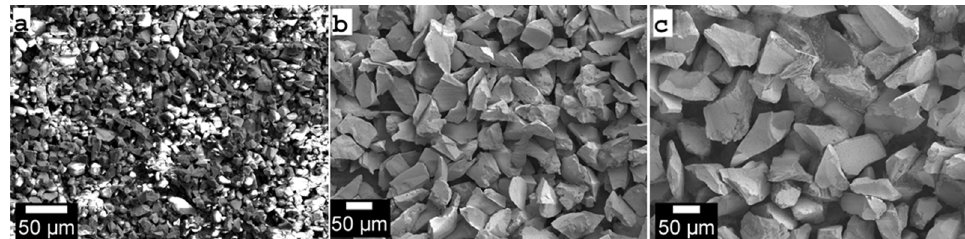
Figure 1. SEM images showing the morphology of fused and crushed alumina powders: ( a ) fine